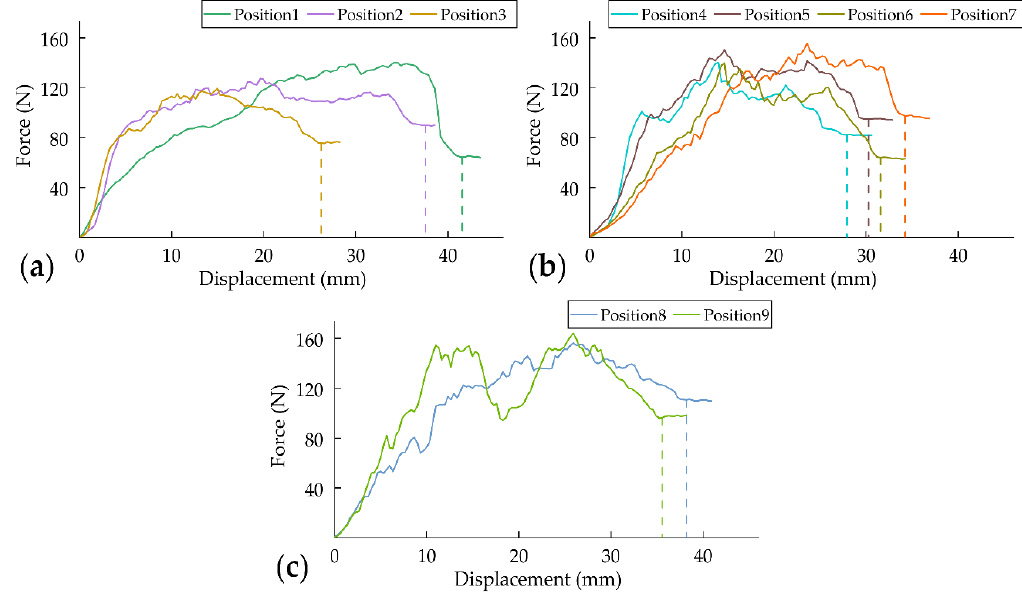
Figure 8. The force–displacement curves at different cutting positions. ( a ) Draws the cutting positions 1–3 in the central stalk–crown transition region (CSCTR), respectively; ( b ) represents the cutting positions 4–7 in the crown expansion region (CER); ( c ) is the cutting positions 8 and 9 in crown–finger transition region (CFTR).